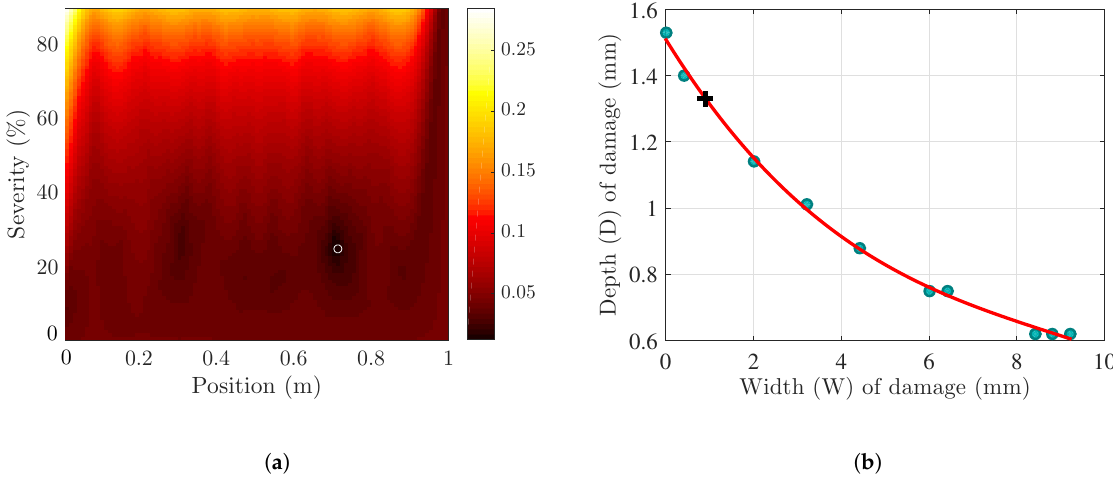
Figure 15. ( a ) FSC as a function of damage position and severity for damage described in Figure 13b; the white circle indicates that the damage position and severity are 0.70 m and 25.35%, respectively; ( b ) width and depth are extracted for 25.35% severity from the damage library (blue dots: raw extraction, red line: cubic fit, black cross: recovered geometry).